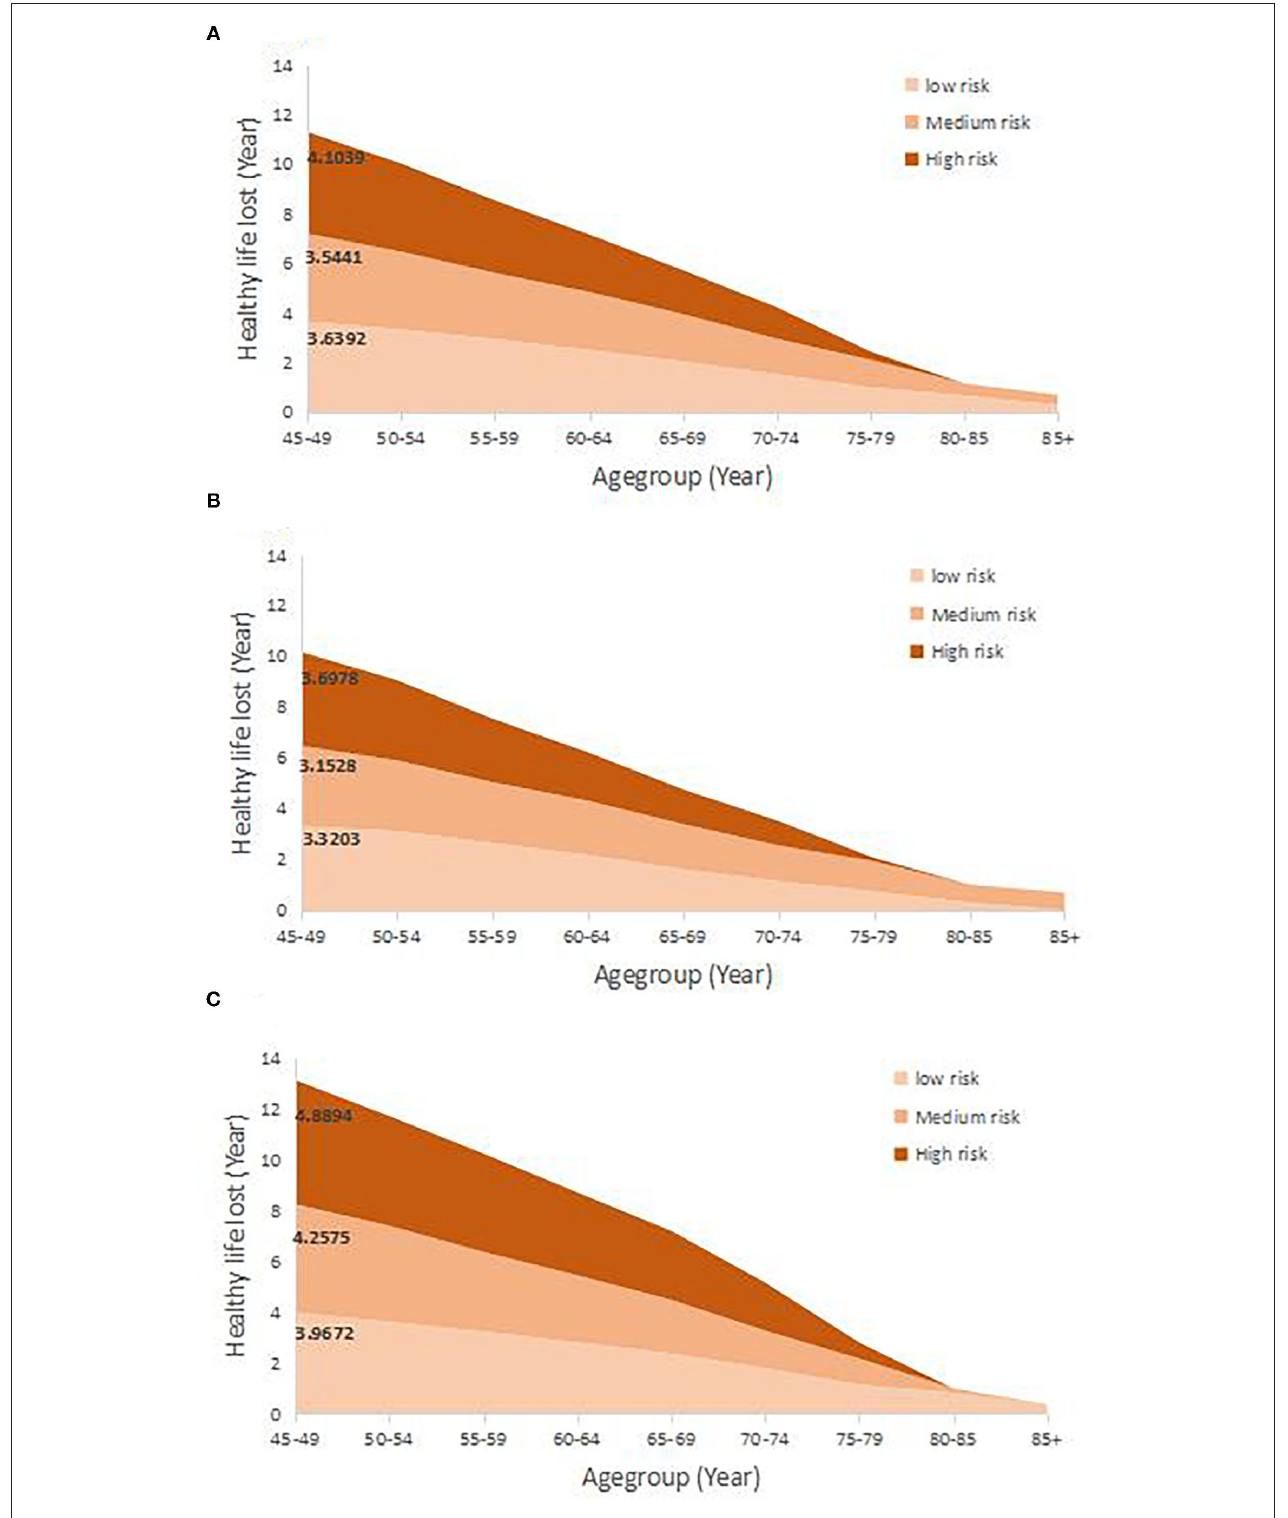
FIGURE 3 | The healthy life years lost due to the multimorbidity in 7-year follow-up. (A–C) Represent the healthy life lost in total population, males and females, respectively.